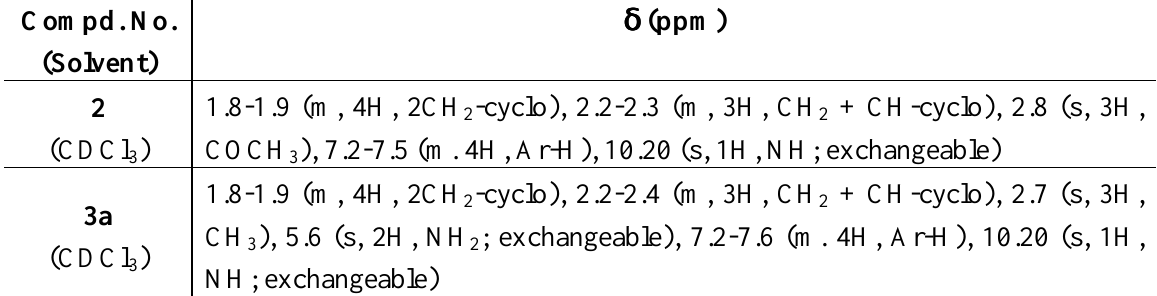
Table 3: 1 H-NMR spectra for some of the synthesized compounds Compd.